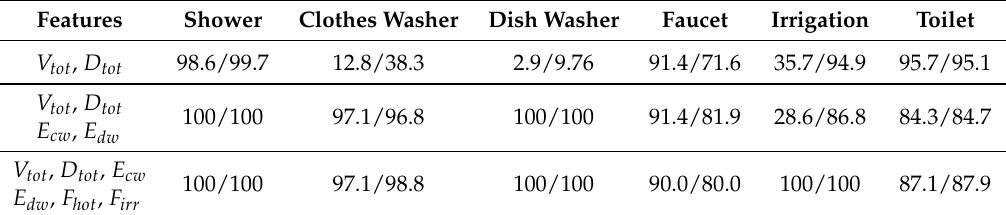
Table 2. A summary of TPR classification rates ( TPR occ / TPR vol ) on the demonstration house dataset for an increasing number of input